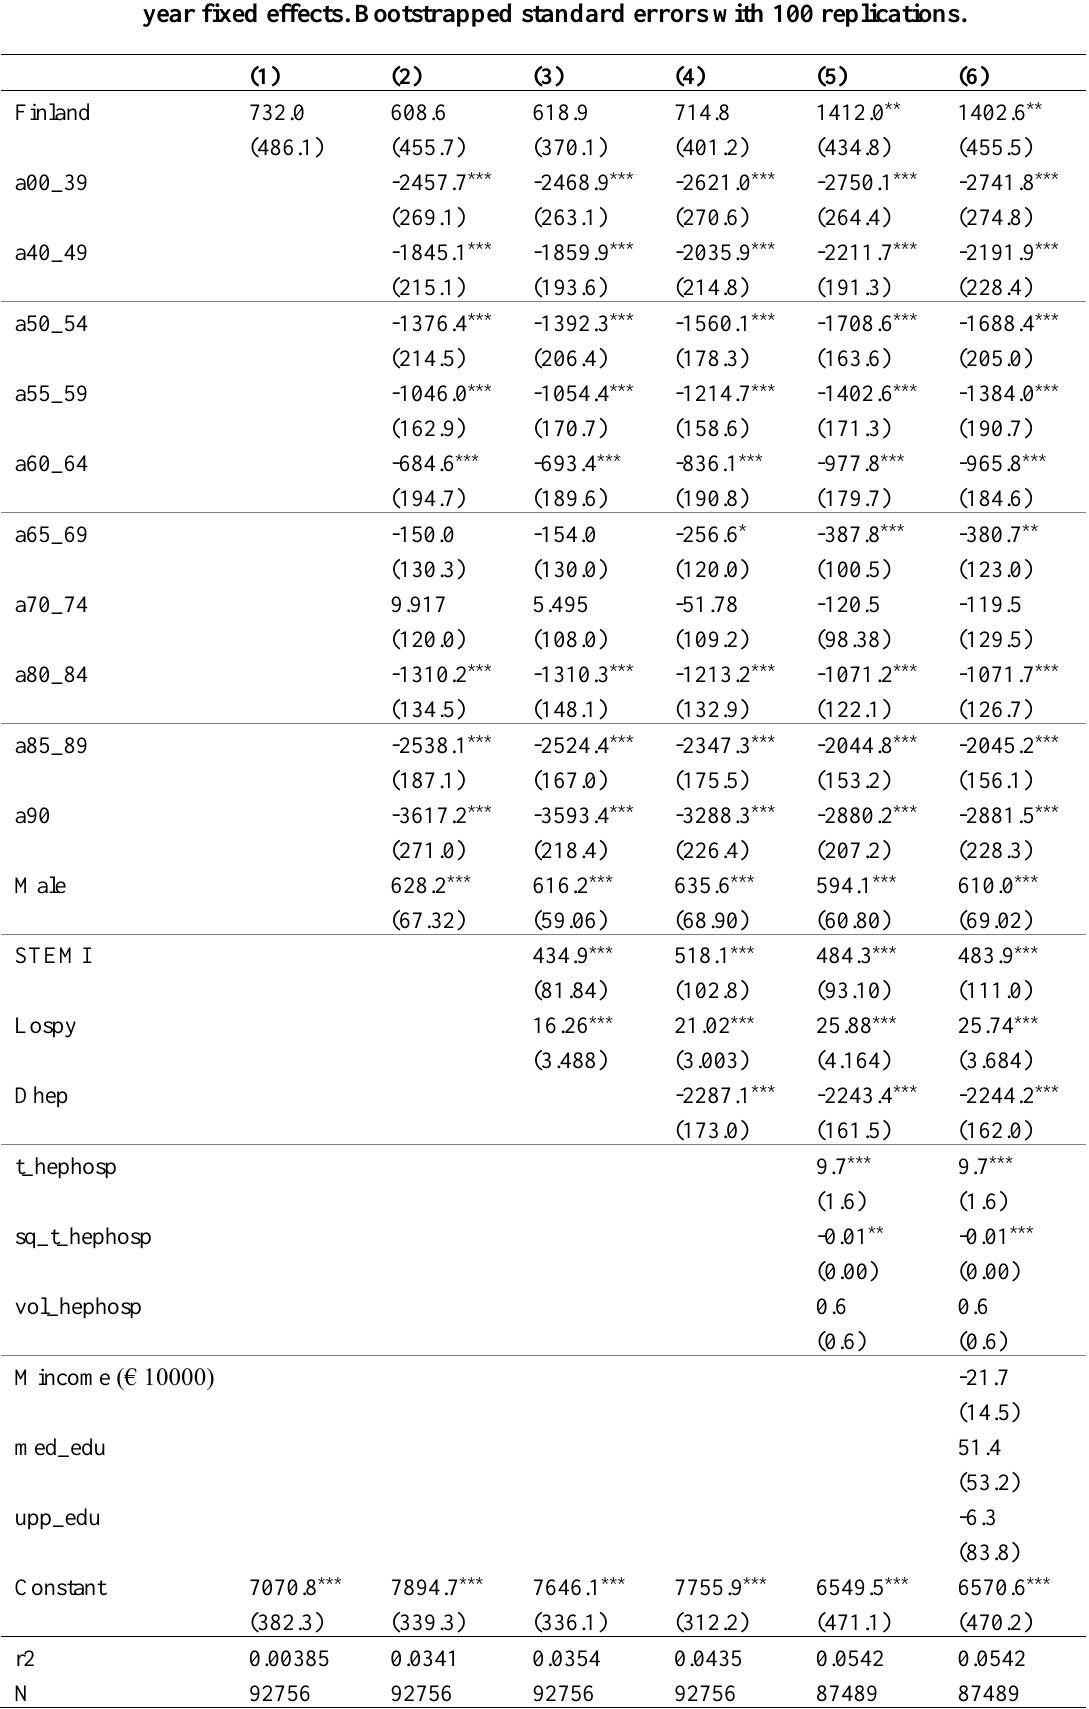
Table 5: HEP cost comparison in Euro by OLS (patients admitted 2009 – 2013) with year fixed effects. Bootstrapped standard errors with 100